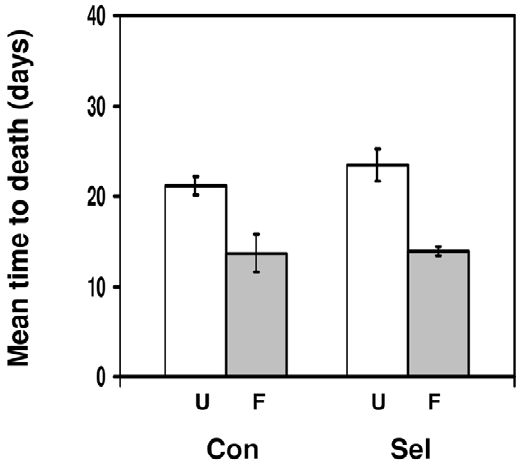
Figure 4. Resistance to microsporidia of flies selected for parasitoid resistance. Early fecundity of Drosophila melanogaster females adult flies that were either infected with Tubulinosema kingi (M; grey bars) or uninfected (U; white bars), depending on whether they had been selected for increased resistance to Asobara tabida (Sel; right side of panel) or had not been selected (Con; left side of panel). Bars